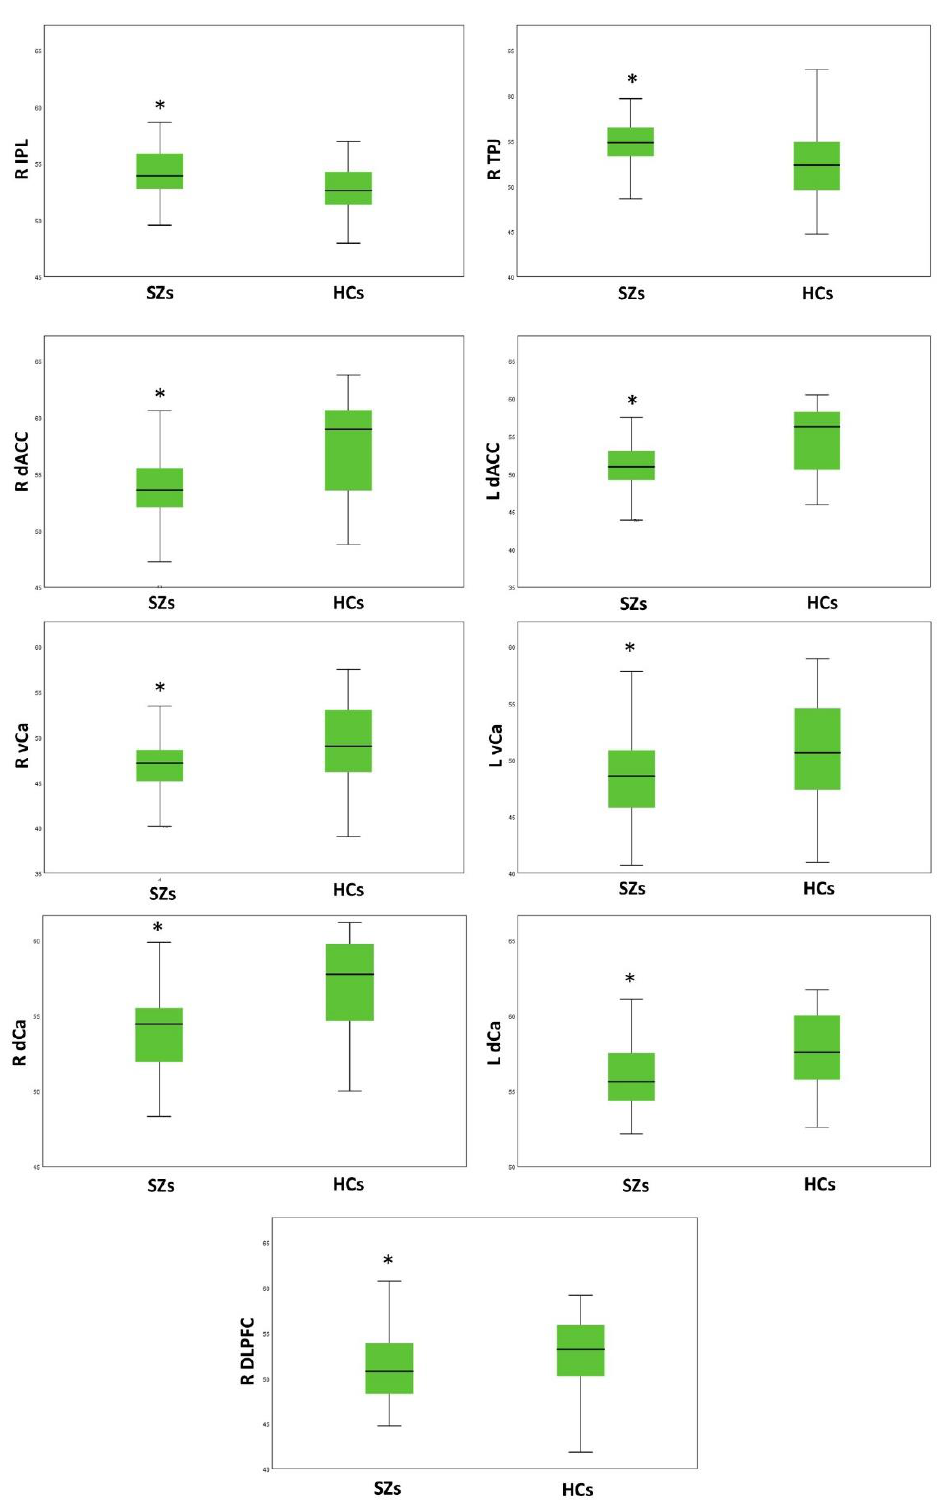
Figure 1. Group comparison on resting-state activity. R: right; L: left; IPL: inferior parietal lobule; TPJ: temporoparietal junction; daCC: dorsal anterior cingulate cortex; vCa: ventral caudate; dCa: dorsal caudate; DLPFC: dorsolateral prefrontal cortex. The SZs, compared to the HCs, exhibit a higher activity of the R-IPL and the R-TPJ, and a reduced activity of the bilateral dACC, the vCa, and the dCa, and the right DLPFC. * The asterisk flags the presence of a significant difference between the two groups in resting-state activity.